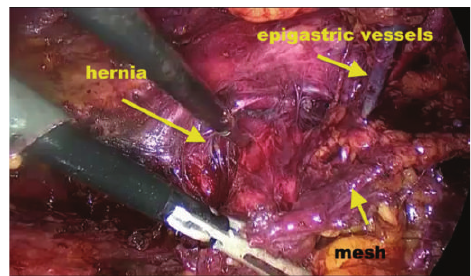
Figure 1: Intraoperative view of the previously placed mesh.